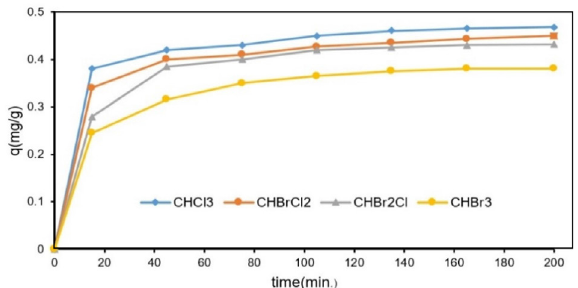
Figure 6A. Adsorption capacity of THMs over the time at the initial concentration of 0.1 mg/L and 10 mg adsorbent at 20 °C